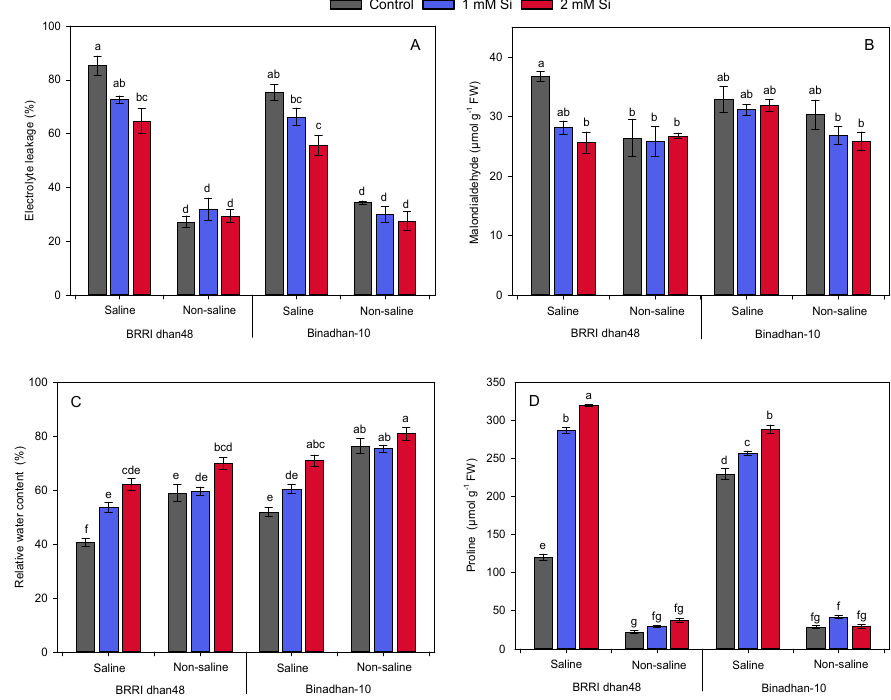
Figure 2. Effect of exogenous Si application (1 and 2 mM silicic acid) on different physiological and biochemical parameters in rice plants subjected to salt stress (10 dSm − 1 ). ( A ) Electrolyte leakage, ( B ) malondialdehyde content, ( C ) relative water content and ( D ) proline content were recorded after six days of recovery from salt stress. Different letters above the bars indicate significant differences among the treatments following Tukey’s HSD test.